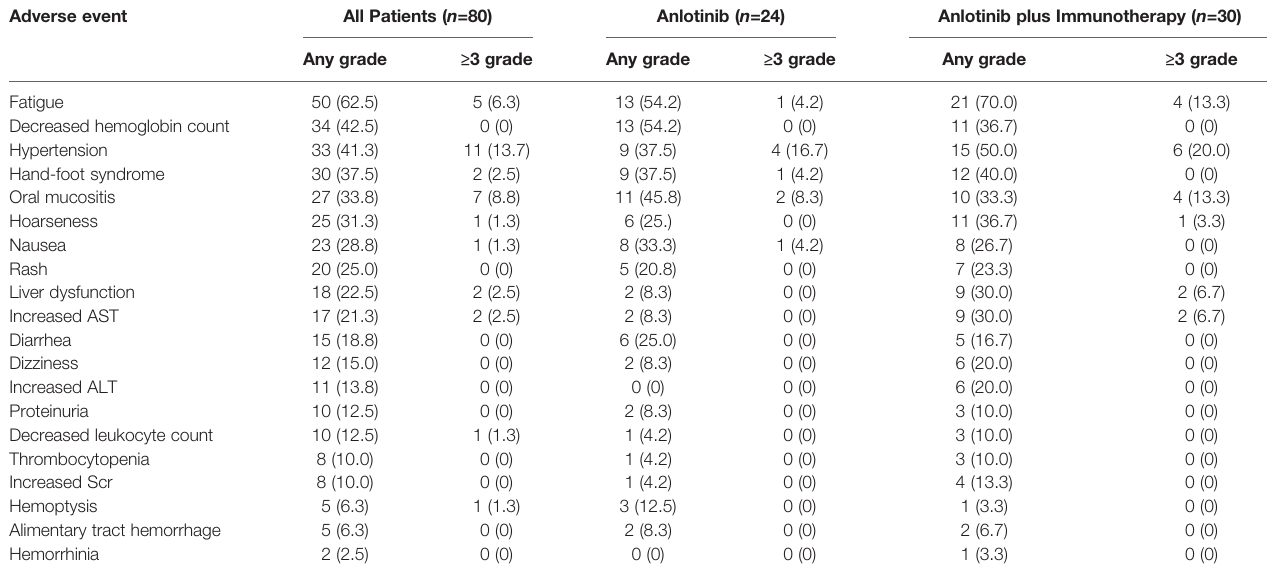
TABLE 6 | Adverse events in patients treated with anlotinib vs . patients treated with anlotinib plus immunotherapy. Adverse event All Patients ( n